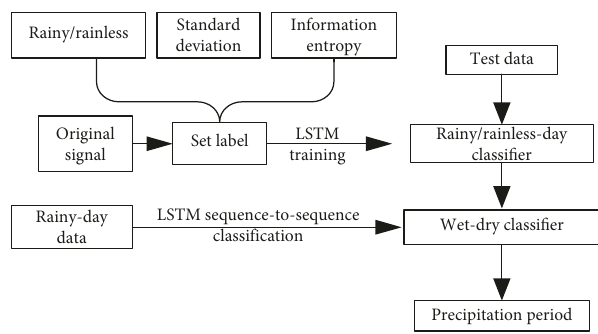
Figure 4: Flow chart of the wet-dry